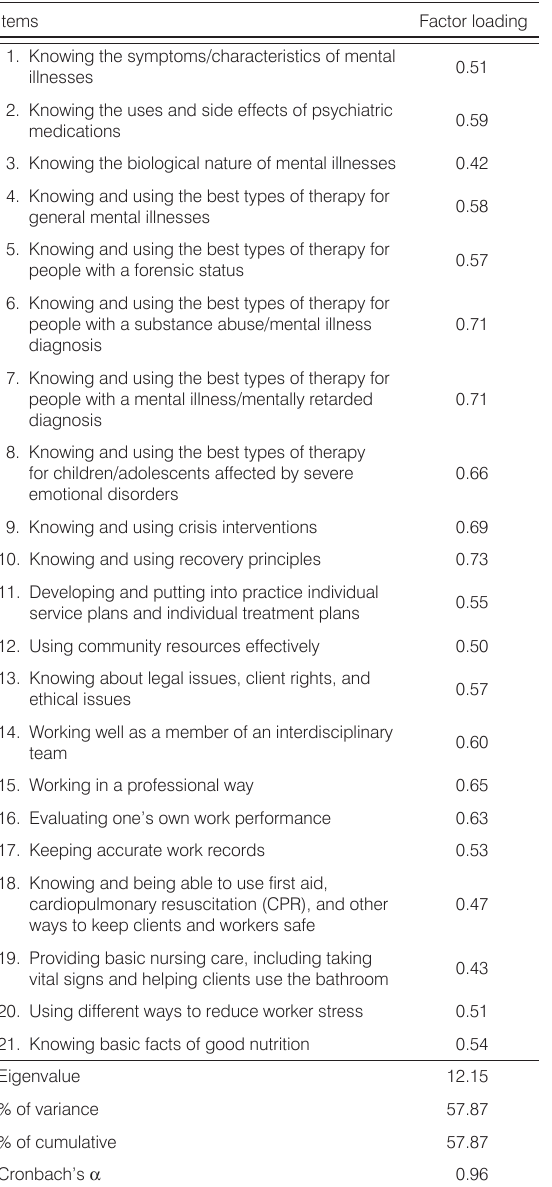
Table 2. Factor analysis of the Competency Assessment Tool-Mental Health (the section on benefits of additional education).